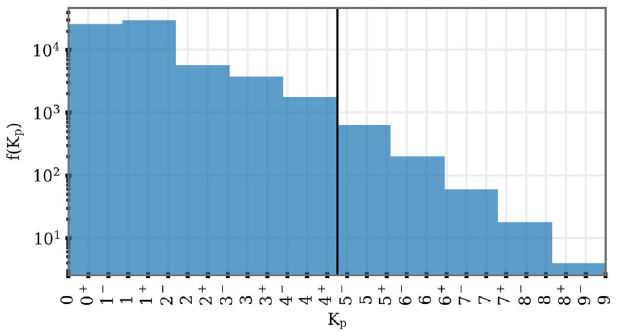
Fig. 3. Distribution of K p . 20 years 1995 – 2014 of data has been used in this plot. f ( K p ) is the frequency (i.e., the number of events) plotted on a logarithmic scale. The black vertical line is K p = 5